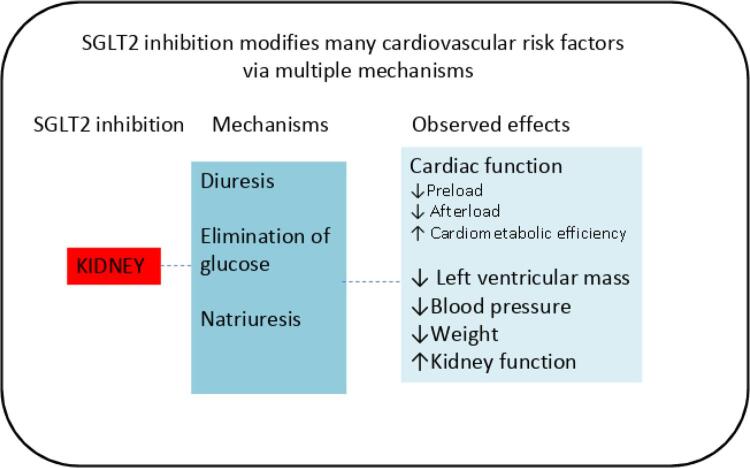
– SGLT2i: mechanisms of action.